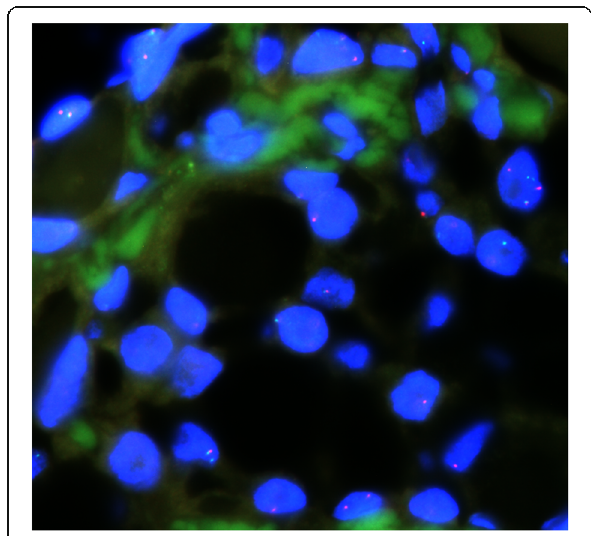
Fig. 5 Tumor cells were shown to have rearrangement of the ETV6 gene. FISH